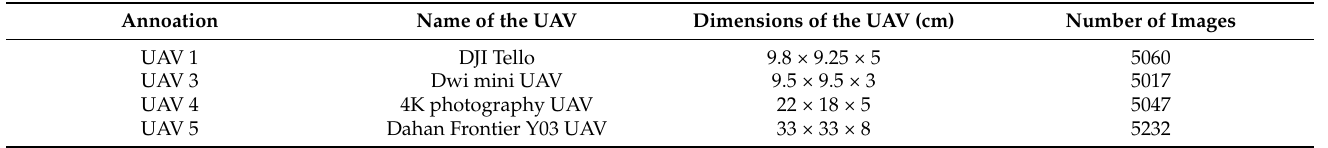
Table 3. Detailed description of the four kinds of UAVs in the